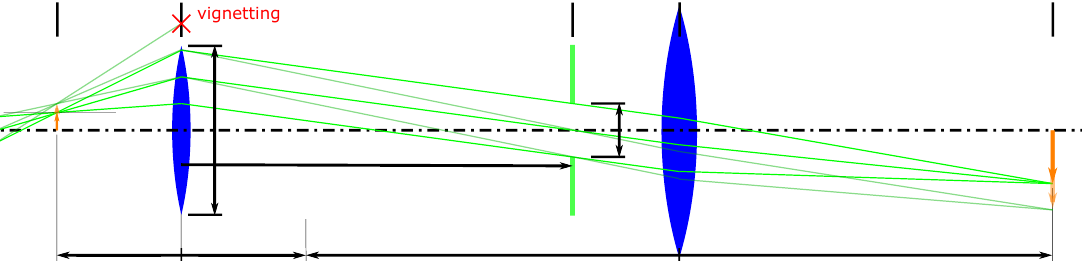
Figure 2. Schematic of a 4f-inspection microscope with hypercentric projection properties. The ray diagram depicts the imaging of two object points with different field heights (two arrows at the position “Obj”). It can be seen that with increasing field height, the principal rays get steeper, producing a stronger parallax effect for the depth estimation in the 3D imaging process. This effect can also be enhanced by increasing the aperture distance d a . The maximal usable parallax effect is limited by the opening of the objective lens D full , defined by its NA , and the diameter of the observation cone D . For the larger object field height, vignetting would occur, which indicates that the d a is too large for the particular